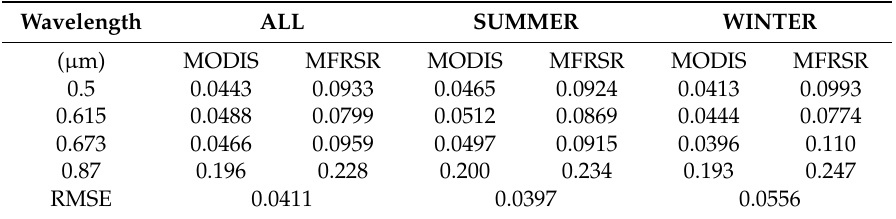
Table 2. MODIS-derived and MFRSR-retrieved spectral values of white-sky albedo at four MFRSR wavelengths (0.5, 0.615, 0.673 and 0.87 µm). These values are obtained for the 19-month period of interest (“all” columns) and two seasons (“summer” and “winter” columns). The corresponding root mean square error (RMSE) is also included (bottom row).